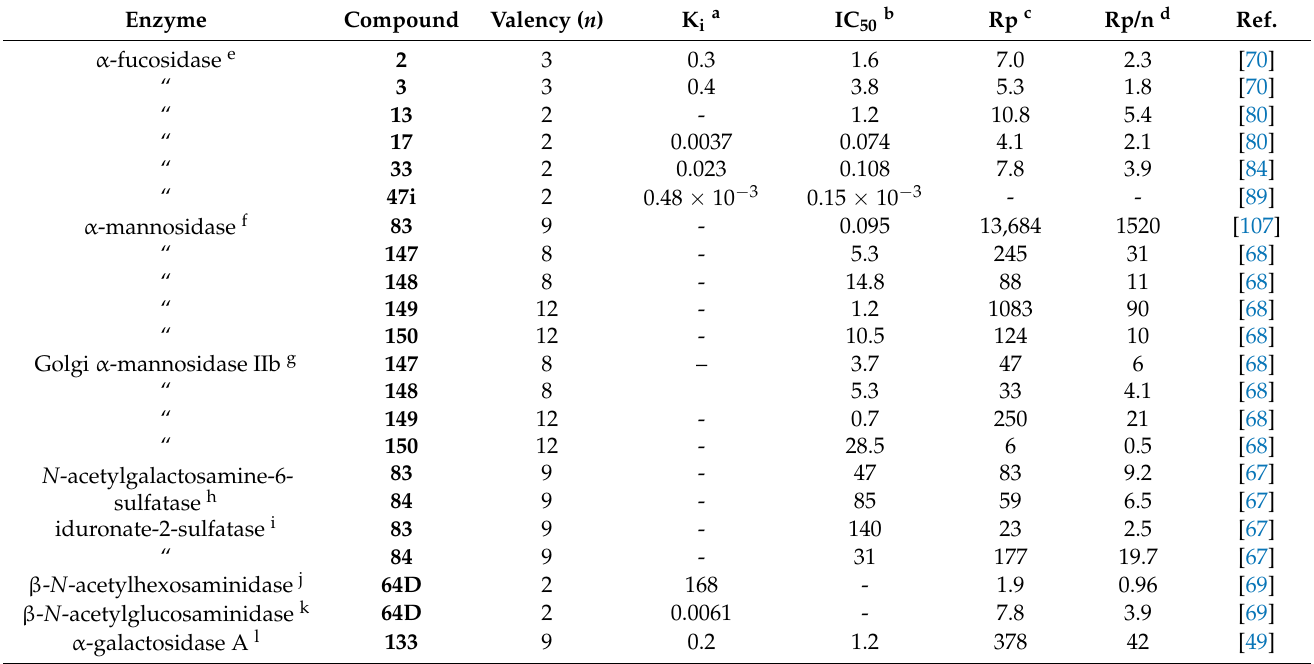
Table 1. Inhibition activities (K i or IC 50 [ µ M]) and relative inhibition potencies (rp and rp/n) of some selected pyrrolidine iminosugars described in the previous section of the present